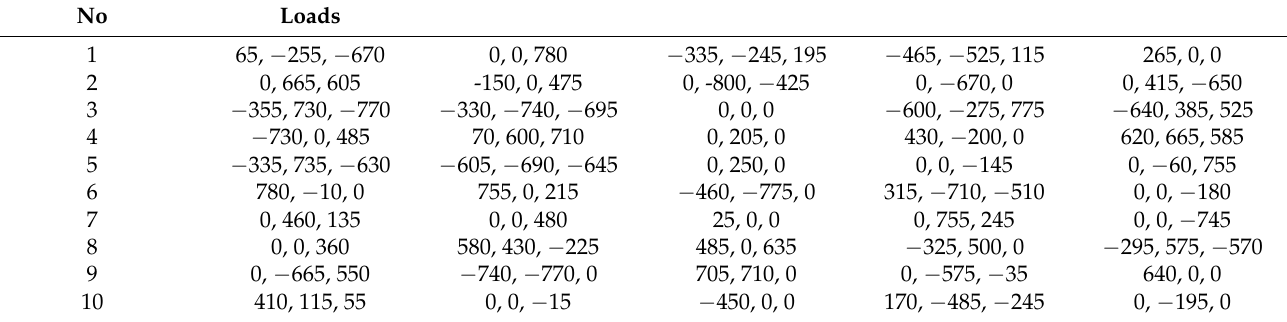
Table 3. Pool of typical loads.